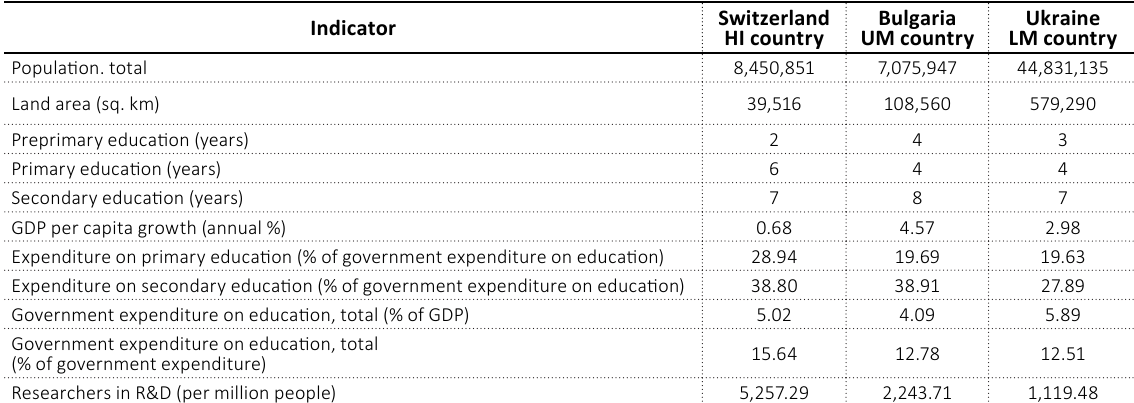
Table 2. General indicators of business environment of the national economies of the studied countries on average for